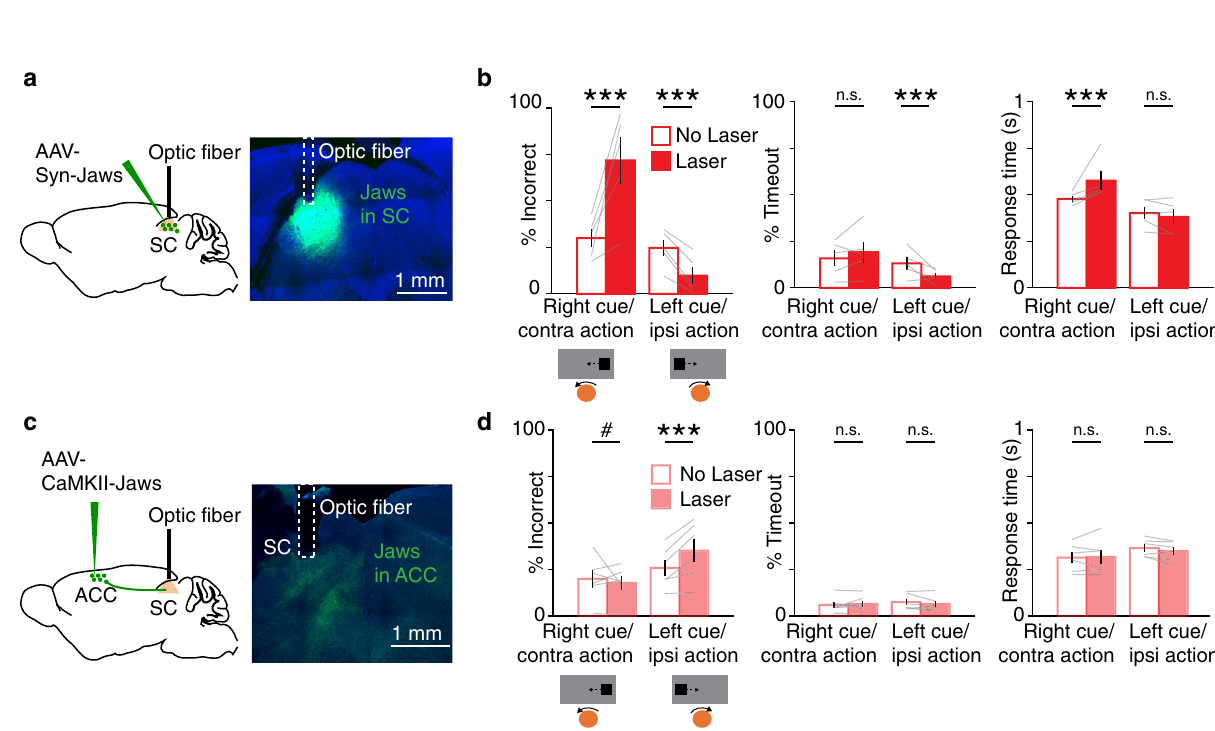
Fig. 3 Task activity of ACC-SC neurons. a ACC-SC neurons were identi fi ed by injecting red retrobeads in the superior colliculus (SC; green, GCaMP6s; red, retrobeads). Recordings were made from 303 ACC-SC neurons in fi ve expert mice (eight behavioral sessions, 1 – 3 sessions per animal). White and red arrows show unlabeled and labeled neurons, respectively. Scale bars: top, 0.5 mm; bottom, 20 µ m. Similar labeling was observed in the fi ve mice tested. b Task responses of an example ACC-SC neuron. Color plot on top shows responses on right and left cue trials with contraversive (contra) and ipsiversive (ipsi) actions on individual trials (rows). Trial-averaged neuronal responses (middle) and trial-averaged ball positions (bottom) for the indicated trial types are shown. Vertical dotted lines show stimulus (stim) onset and horizontal dotted lines show ball position of 0. c Session-averaged activity of individual ACC-SC neurons for the indicated trial type. Each row corresponds to the same neuron across the four plots. Dotted line shows stimulus onset. d Average z -scored ( z -scr) responses on right and left cue trials with contraversive and ipsiversive actions (right cues, contraversive vs. ipsiversive: p = 0.046, z = − 2.00; left cue, contraversive vs. ipsiversive: p = 0.0076, z = − 2.69; n = 303 neurons from fi ve mice). * p < 0.05, ** p < 0.005, two-tailed Wilcoxon signed- rank test. Box plot conventions are same as Fig. 2g. e Percentage of ACC-SC neurons with a signi fi cant difference in response to contraversive vs. ipsiversive actions for right and left cues ( n = 303 neurons from fi ve mice). Error bars are 95% binomial con fi dence intervals. f Classi fi er accuracy for action decoding with ACC-SC neurons recorded across all sessions. Dotted line shows chance model performance obtained by shuf fl ing trial labels on the test set. Mean classi fi er accuracy ± the standard deviation over 1000 iterations of the model is shown ( n = 8 sessions from 5 mice). g Classi fi er accuracy for action decoding on individual sessions with ACC-SC and unlabeled neurons ( n = 7 sessions from four mice; p = 0.018, z = 2.37). * p < 0.05; two-tailed Wilcoxon signed-rank test. Error bars are mean ± standard error of the mean.